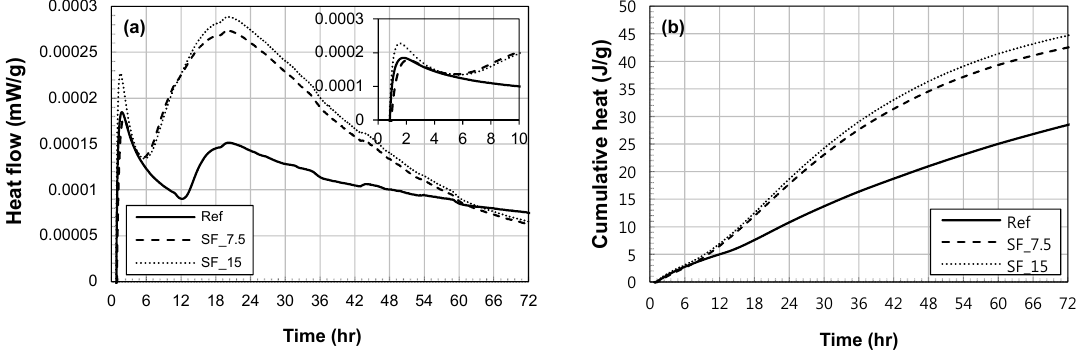
Figure 3. Heat of hydration of kaolinite clay based mortars with SF contents: hydration heat flow evolution ( a ), and cumulative heat of hydration ( b ).